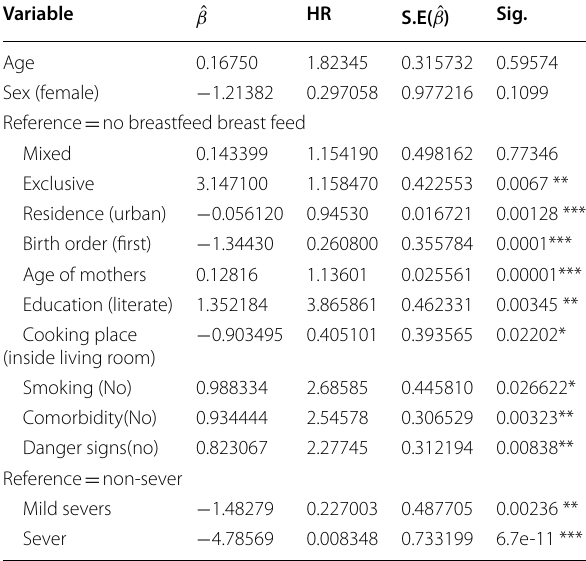
Table 1 Cox proportional hazard results to determine the time of recovery among children under five pneumonia patients in Felege Hiwot Referral Hospital, Bahir Dar,